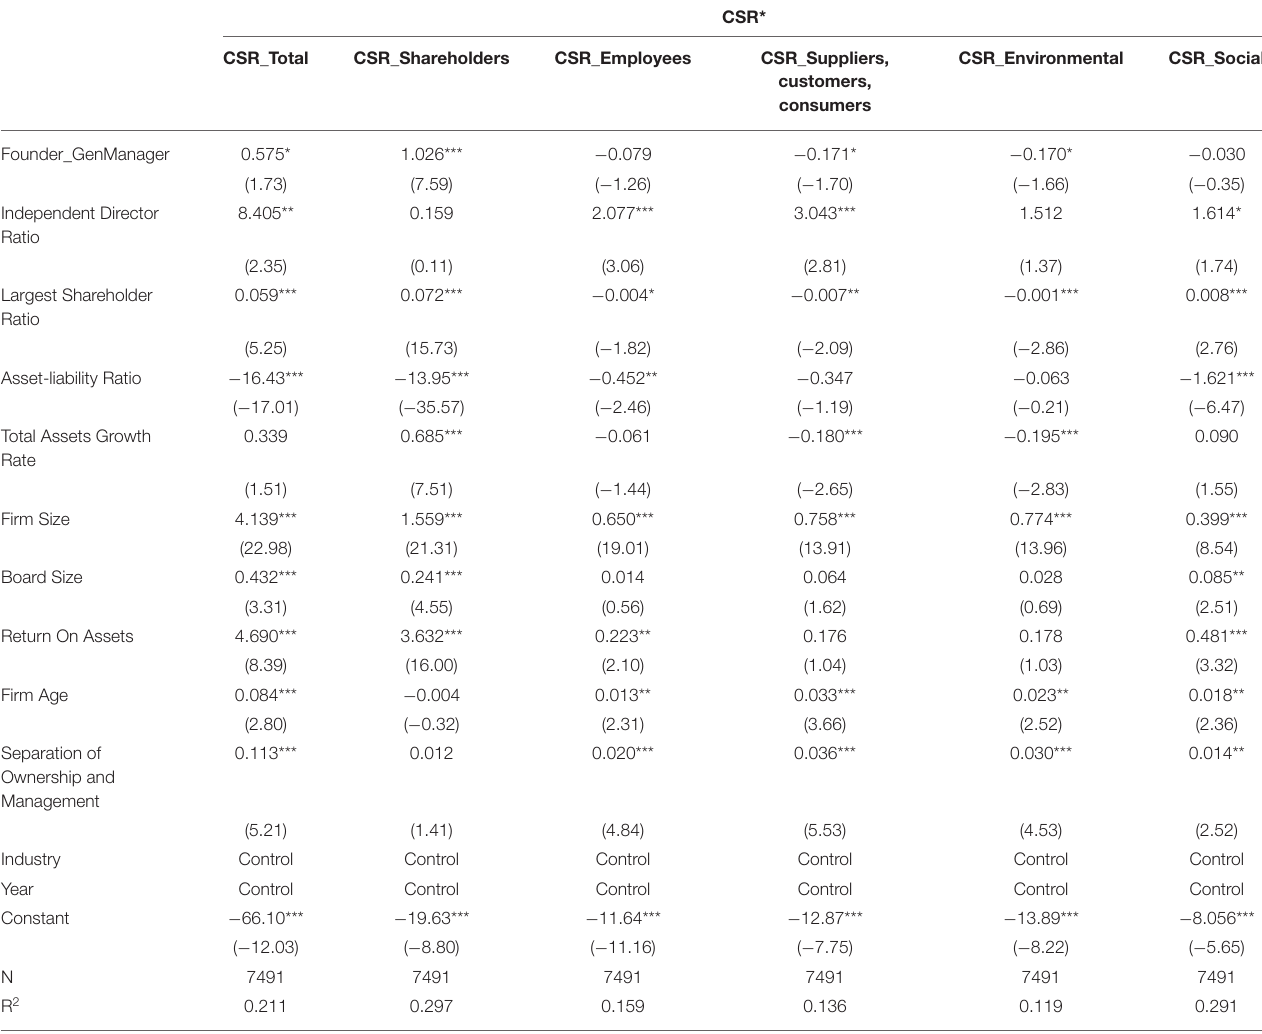
TABLE 10 | Regression results (founder general manager and